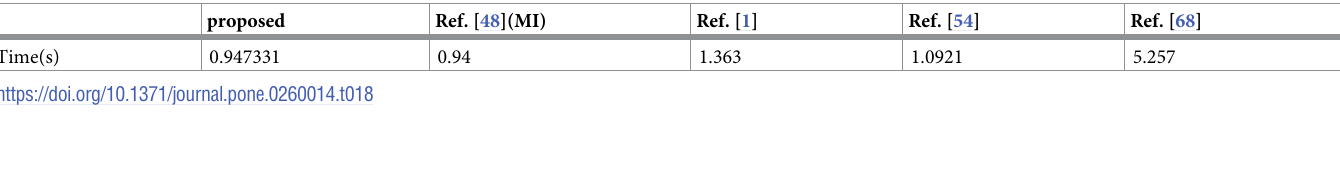
Table 18. Comparison table of encryption and decryption time.